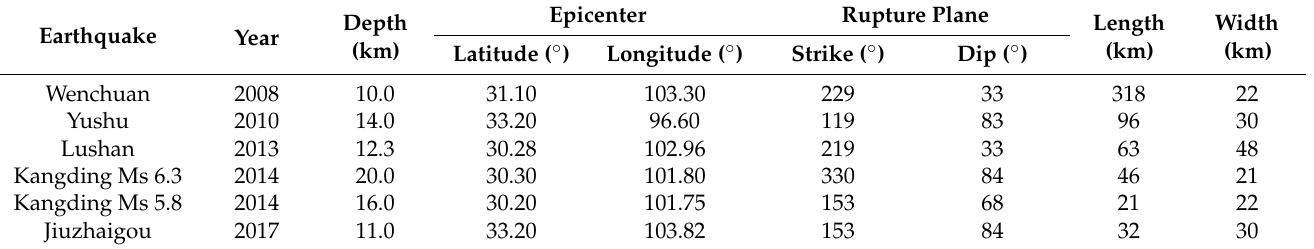
Table 3. Earthquake parameters for the six source models. The epicenters of the 2008 Ms 8.0 Wenchuan earthquake and the 2013 Ms 7.0 Lushan earthquake are from the USGS. The epicenters of the 2010 Ms 7.1 Yushu earthquake, the 2014 Ms 6.3, Ms 5.8 Kangding double earthquakes, and